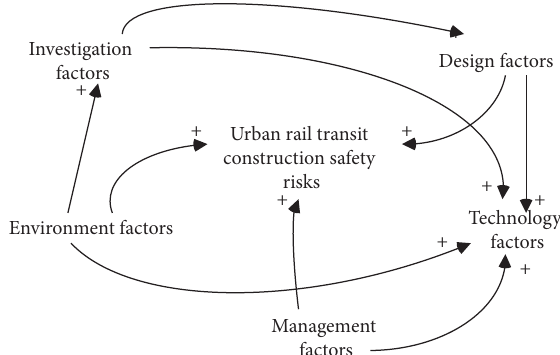
Figure 3: Causal loop diagram of risk factor